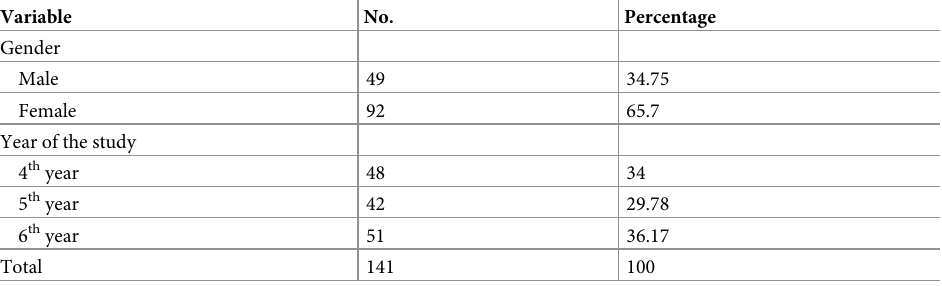
Table 1. Demographic distribution of the